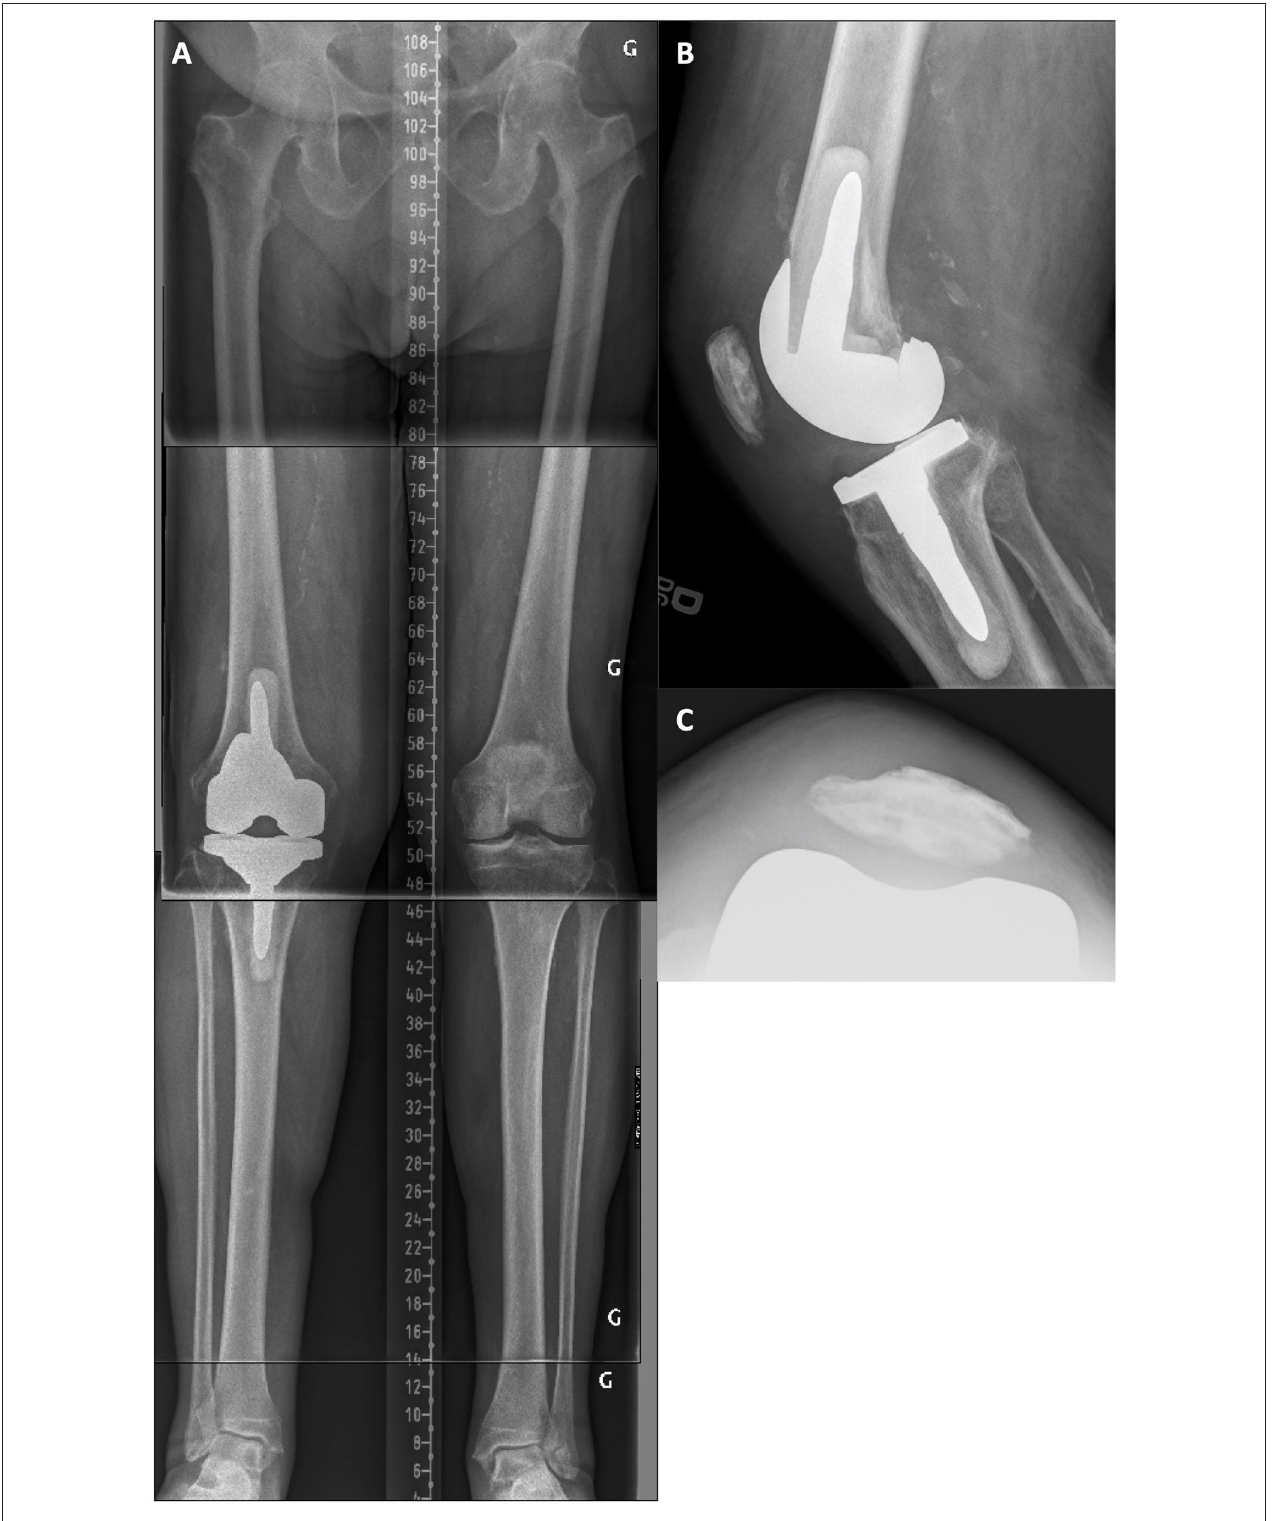
FIGURE 8 | (A) Post-revision standing long-leg X-ray of the right lower limb where the implant mDFA has been modified to 1.0 ◦ valgus and the mPTA at 0.5 ◦ varus (0.5 ◦ valgus aHKA). (B) Right knee lateral view where the implant tibial slope has been shifted from 1.5 ◦ anterior to 2.0 ◦ posterior. The femoral implant has also been translated posteriorly to be flush with the anterior cortex. (C) Right knee skyline view showing a well-centered resurfaced patella.